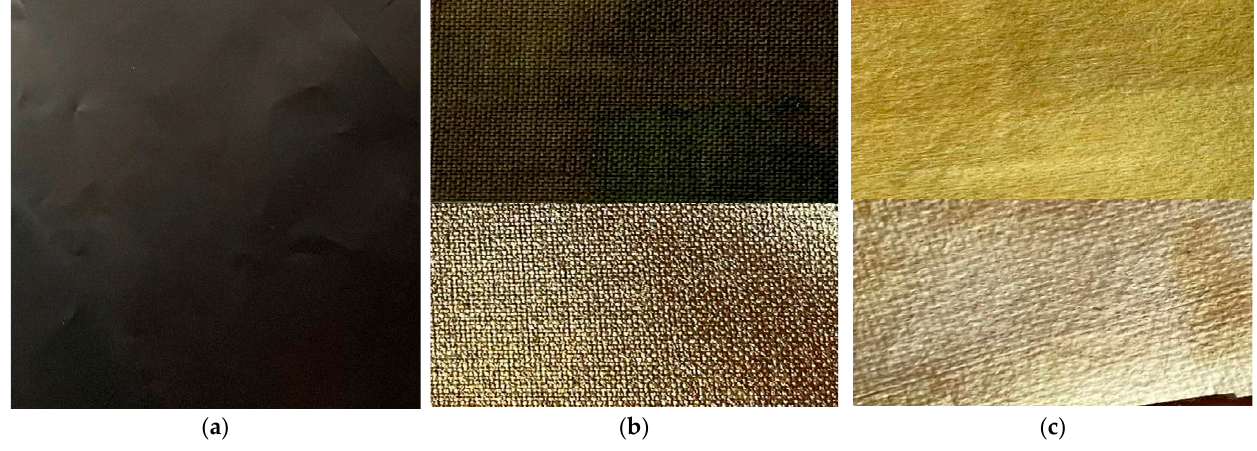
Figure 1. The photo of two sides of the materials (front and back) used for the research: ( a ) Velostat, ( b ) Cordura, ( c ) Goretex membrane.